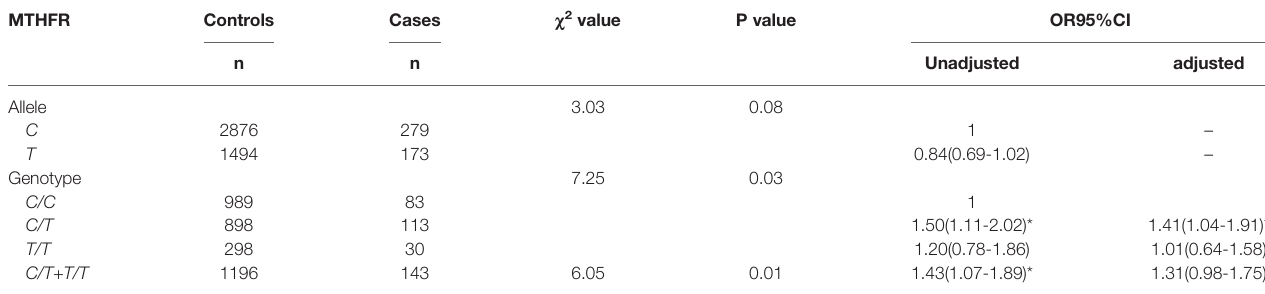
TABLE 2 | Correlation analysis between UF and MTHFR C677T polymorphism. MTHFR